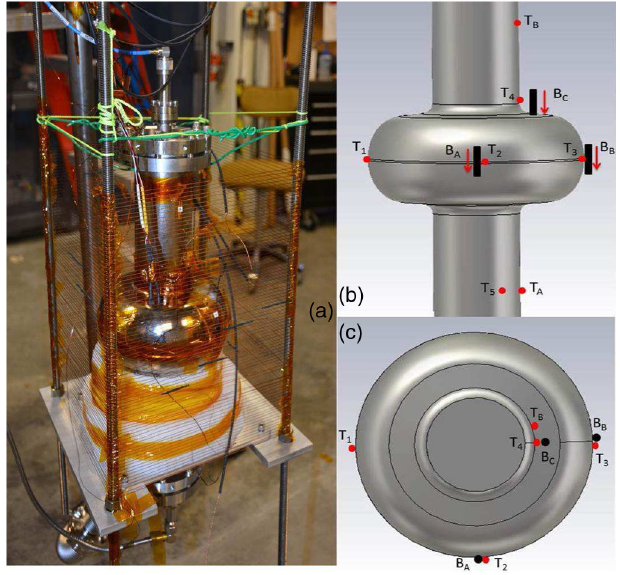
FIG. 1. Experimental setup: A 1.5 GHz single cell cavity located on test stand (a), its front view (b), and top view (c). Red filled circles and black rectangular symbols represent temperature sensors and magnetometers,